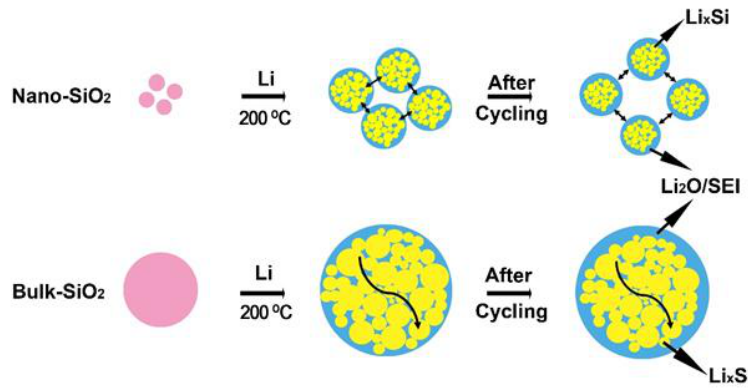
Figure 5. ( a ) Cycling performance of four Li x Si/Li 2 O samples at C/20 (1C = 1.96 A g −1 Li x Si, the capacity is based on the total mass of Li x Si in the electrode). The green line is the Coulombic efficiency of Li x Si/Li 2 O-4 composite; ( b ) Rate stability of Li x Si/Li 2 O-4 composite.